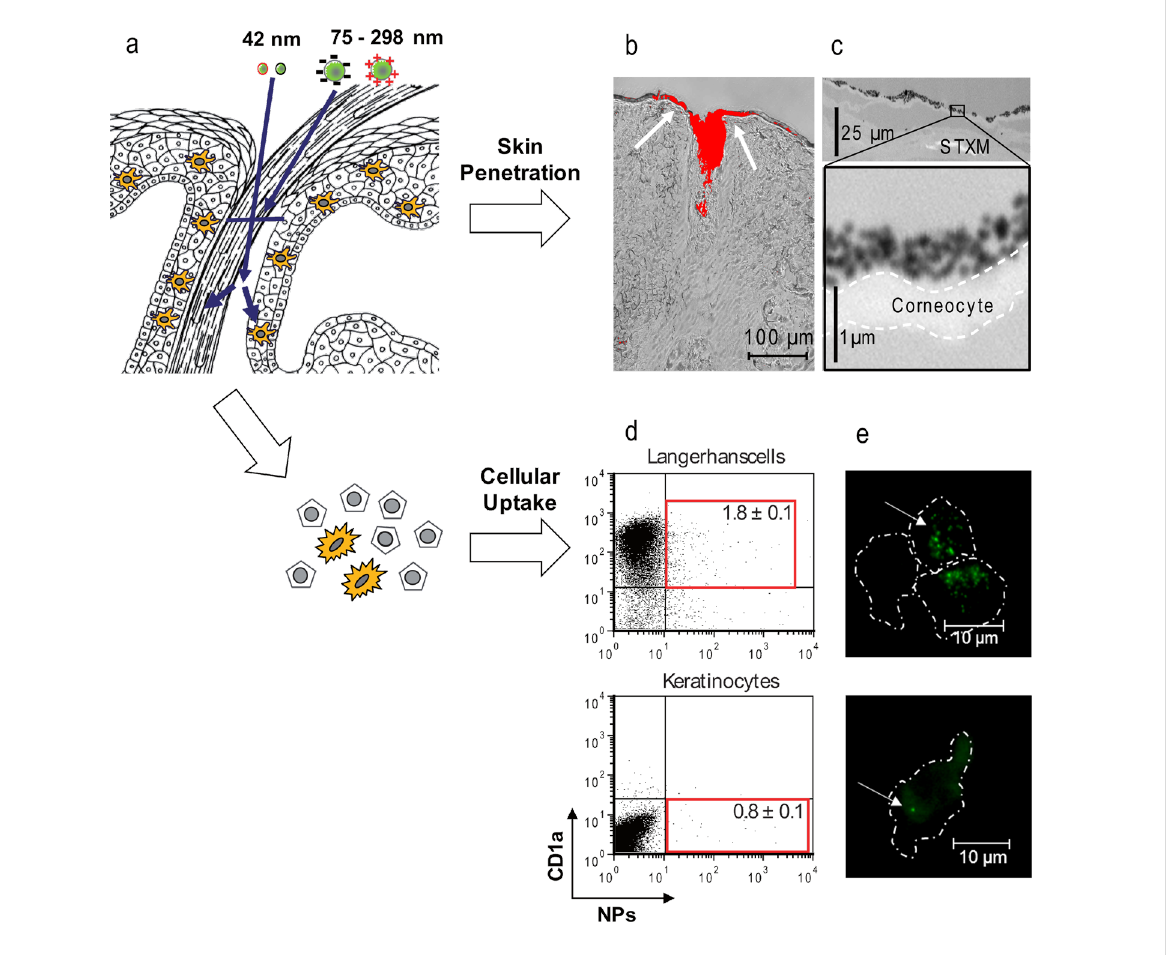
Figure 1: Interdisciplinary set-up to study skin penetration and cellular uptake of amorphous silica particles in human skin explants. Silica particles with 42, 75 or 300 nm diameter were applied on excised human skin to study penetration and cellular uptake (a). Labeling of particles with fluorescein enabled the visualization of particle accumulation on skin sections and in hair follicle openings by using fluorescence microscopy (b). However, single particles on the skin surface could only be visualized after preparation of silica particles with gold cores and skin section analysis by using scanning transmission X-ray microscopy (STXM) (c). Whereas particles with a size ranging between 75 and 300 nm accumulated on the horny layers and in hair follicle openings without deeper penetration, flow cytometry of single cell suspensions prepared from skin tissue pretreated with fluorescent 42 nm particles identified a small percentage of cells associated with particles (d, boxed areas in representative flow cytometry images). Single cell fluorescence microscopy confirmed the presence of cell-associated particles that are highly suggestive for cellular uptake (e). (Figure 1a,b,d,e modi- fied with permission from [3], Copyright 2012 American Chemical Society; Figure 1c modified with permission from [4], Copyright 2009 Society of Photo Optical Instrumentation Engineers.)